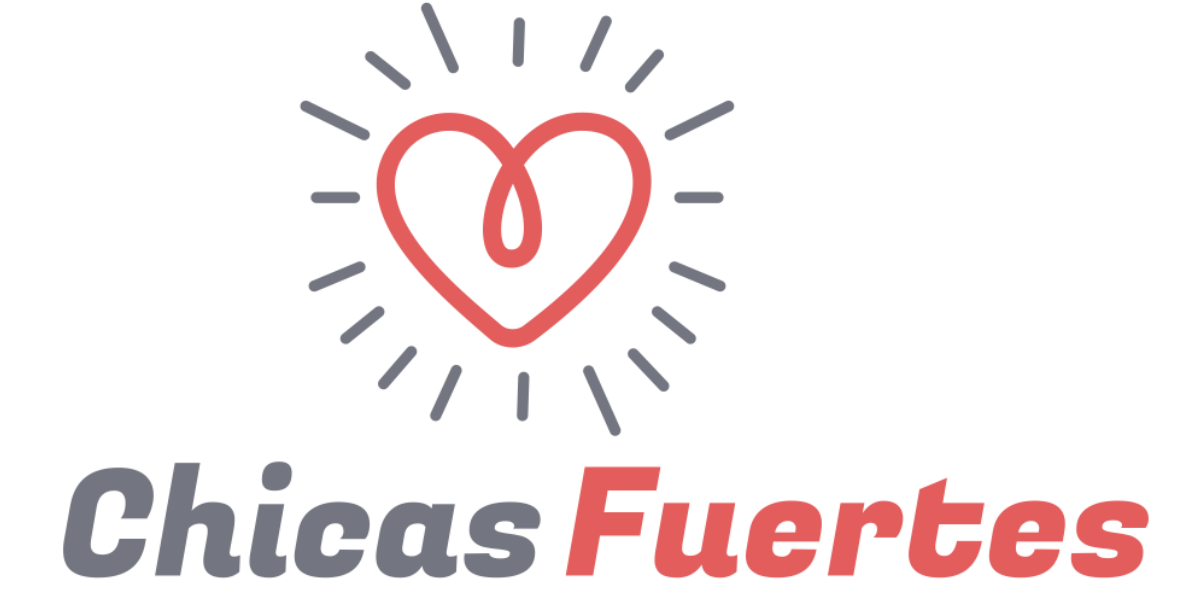
Figure 2. Chicas Fuertes study logo.